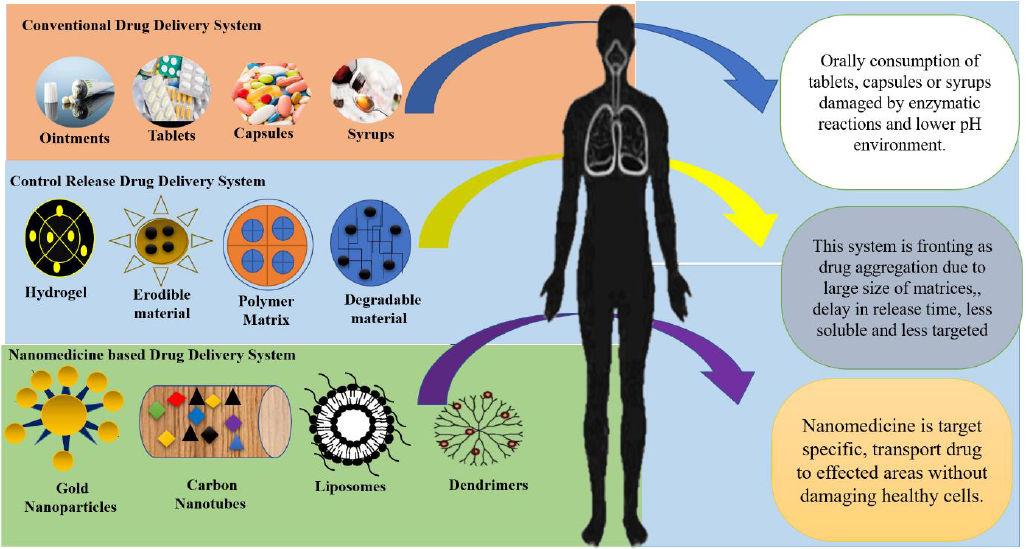
Figure 1. Illustration of how traditional medications were administered without the use of nanocarriers and harm was done to healthy organs or cells. In contrast, modern procedures use nanomedicines to transport medications to specific parts of the body.